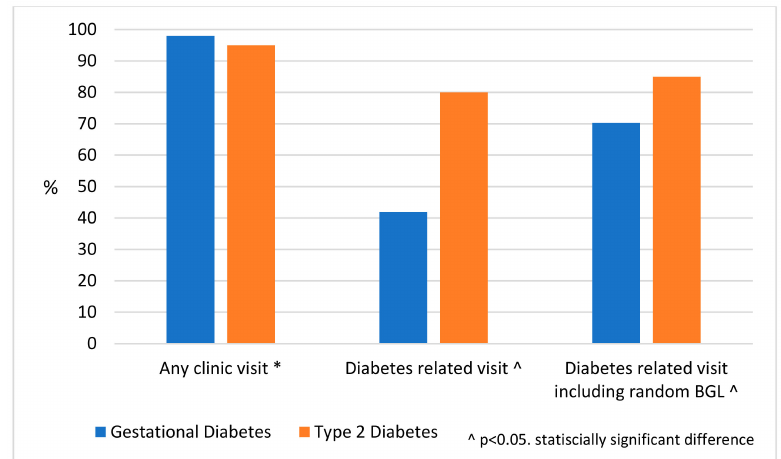
Figure 3. Number of visits to the health centre following diabetes in pregnancy in the 12 month postpartum period in the Northern Territory, 2013–2014, by diabetes in pregnancy type. Data are percentages. * As a percentage of all women in the study. ˆ As a percentage of women who had any visit to the clinic in the 12 month postpartum period. BGL, blood glucose